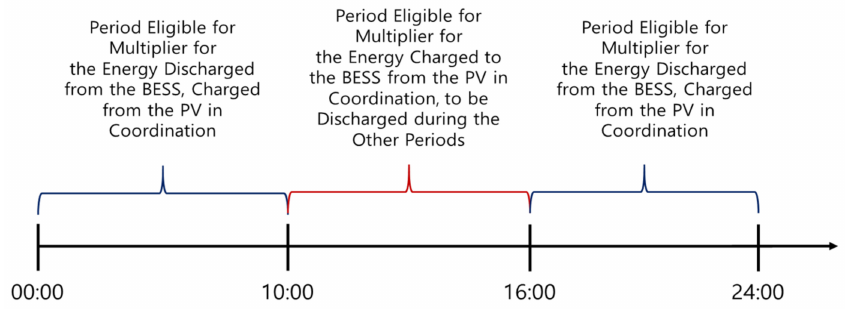
Figure 5. Scheduling windows for the DER with the PV considering multiplier applicability.